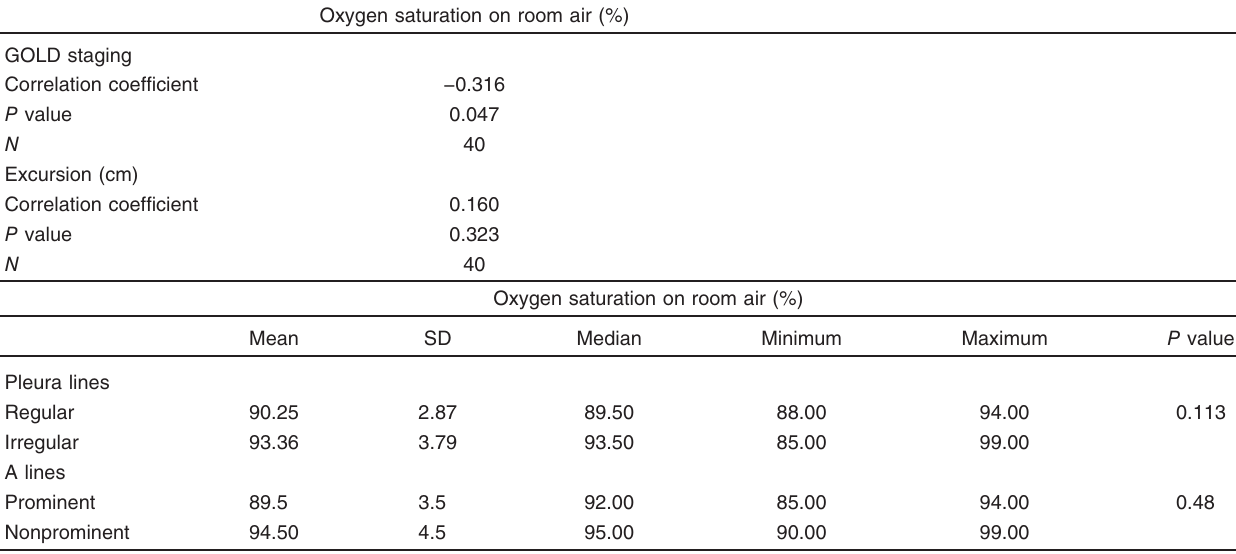
Table 6 Correlation between oxygen saturation and diaphragmatic excursion, Global Initiative for Chronic Obstructive Lung Disease staging, pleura lines, and A